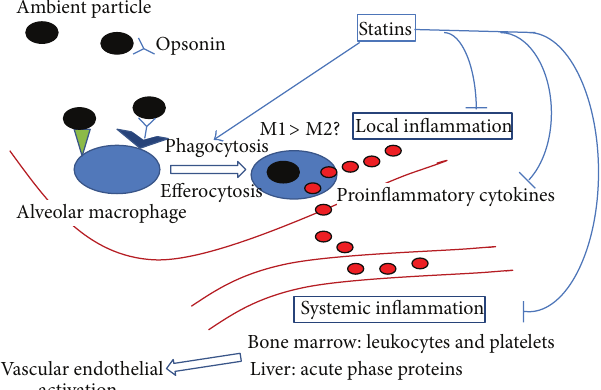
Figure 6: The potential impact of the 3-hydroxy-3-methylglutaryl coenzyme A reductase inhibitors (statins) on both the local (lung) and systemic inflammatory responses induced by exposure to PM. Statins enhance both the opsonized and unopsonized phagocytosis of PM by AMs, potentially promoting the switching of M1 to M2 macrophages (promoting resolution of inflammation), and reduce the production of proinflammatory mediators produced by macrophages when exposed to PM as well as reducing the translocation of these mediators into the systemic circulation. These effects attenuate the systemic inflammatory response induced by PM as well as the downstream adverse vascular effects (endothelial dysfunction and progression of